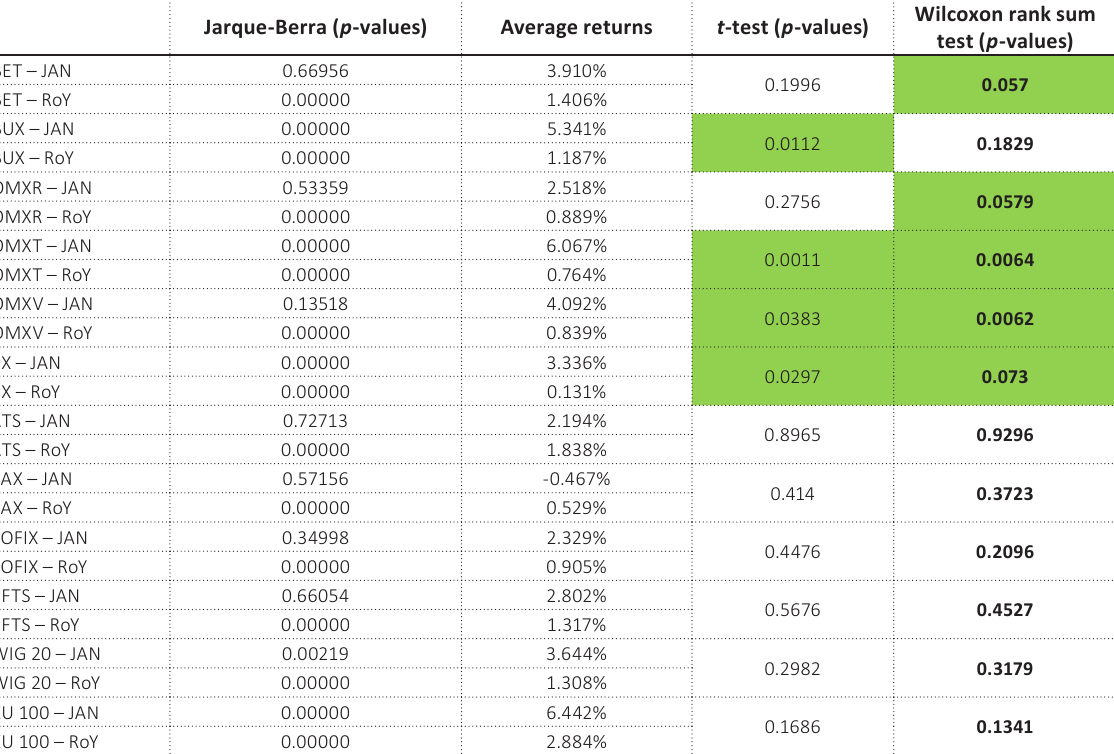
Table 2. January effect statistical significance test results (returns)